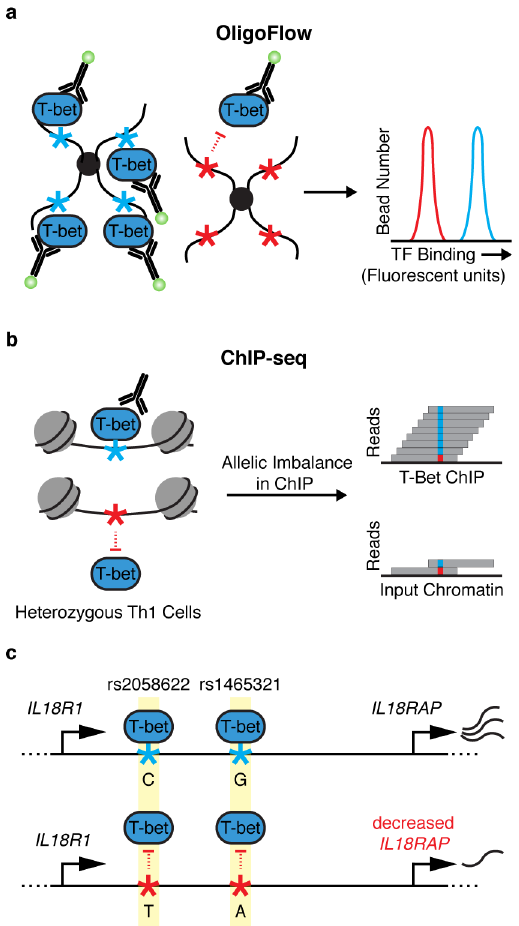
Fig 1. Identifying noncoding variants that impair transcription factor (TF) binding. (a) OligoFlowis a flow-cytometry–based methodfor rapidscreeningof DNA variantsthat affect TF binding.In brief,celllysate is mixedwith bead-coupled oligonucleotides containing a T-bet bindingsite (lightblueasterisk,left panel)or without (red asterisk,right panel)a candidatediseasevariant.Samplesare incubated with a fluorochrome-labeled antibodyagainstT-bet, andbindingaffinity is measuredby flow cytometry. (b) chromatinimmunoprecipitation sequencing (ChIP-seq) allowsfor the assessment of TF bindingin its nativechromatincontext. Soderquest et al., confirmedallelicimbalanceof T-bet bindingto 2 linkedSNPs (rs1465321andrs2058622)at the immunerisk locus IL18RAP (c). TheseSNPs are associated with decreased expressionof the gene[11],suggestingthat they affect T-bet–dependent regulationof IL18RAP . IL18R1/IL18RAP locusnot drawnto